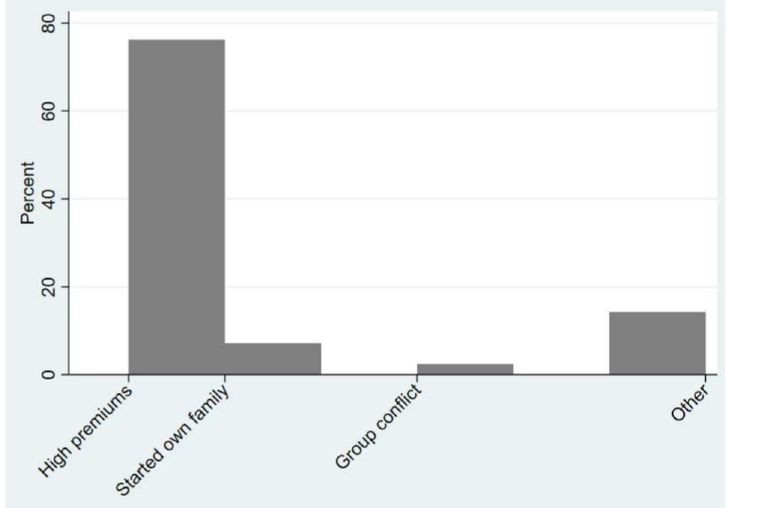
Fig 1. Reasons for dropping out of